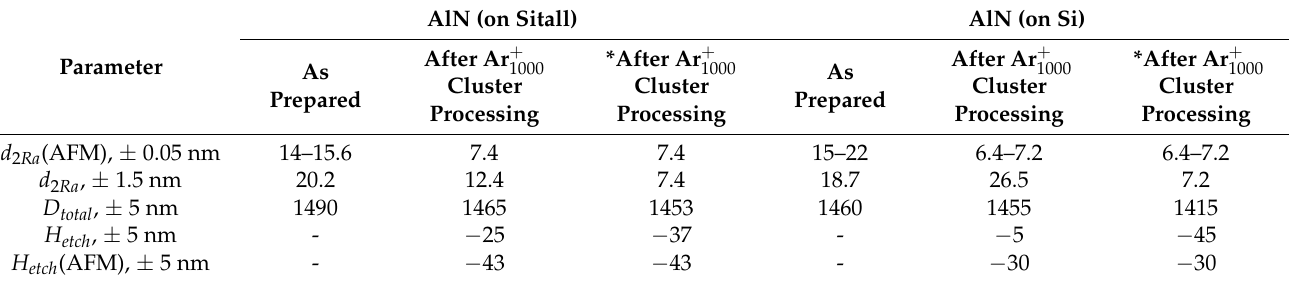
Figure 6. The optical constants dependencies on wavelength λ for the AlN layer: ( a ) the refractive index n as-prepared and after low-energy mode on the Sitall substrate; ( b ) the absorption index k on Sitall; ( c ) the refractive index n on Si; and ( d ) the absorption index k on Si. Parameter errors: δ n = 0.01 and δ k = 0.002. Table 3. Ellipsometric and AFM data of AlN thin